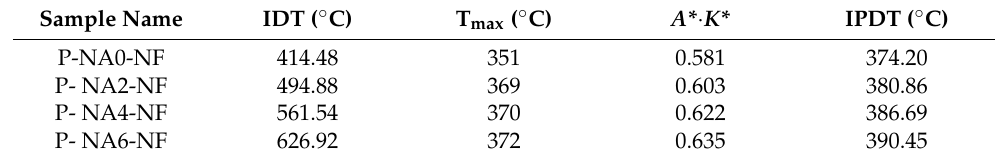
Table 3. Thermal stability parameters of the NF-reinforced PLA composites with different NA